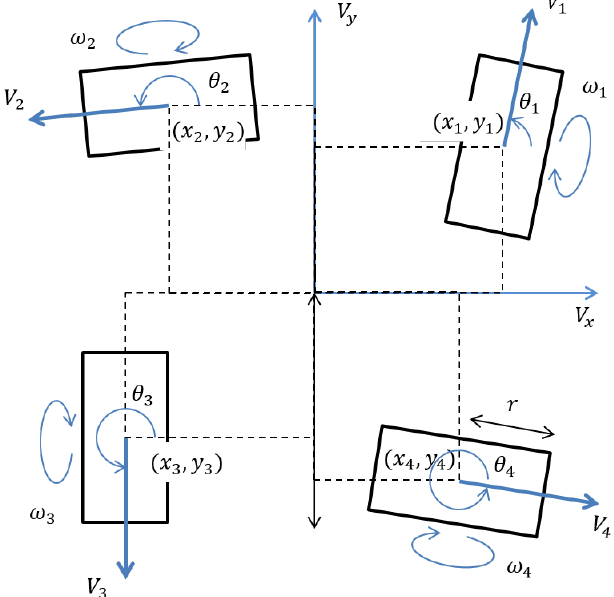
Figure 2. Pattern diagram of the four-wheel robot: The parameters of each wheel of a four-wheel robot are shown when a wheel of radius r is placed at position ( x , y ) and direction θ . V x and V y are the frontal and leftward velocities of the robot, respectively, and ω and V are the rotational and ground speeds of the